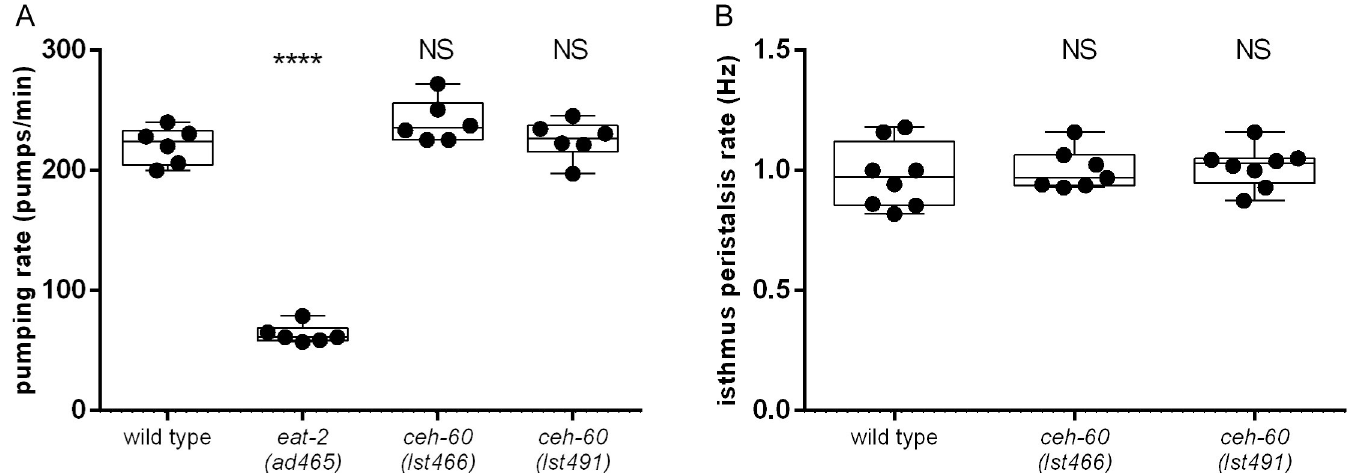
Fig 4. ceh-60 mutants have normal pharyngeal functions. (A) Wild-type animals and ceh-60 mutant animals have similar pumping rates on food, while eat-2 mutants pump significantly slower. Each dot represents one animal (N), imaged thrice for 15 seconds. Pumping rates were averaged per animal. ���� p < 0.0001. NS = not significant. N = 6. (B) Wild-type animals and ceh-60 mutants have similar isthmus peristalsis or “gulp” rates. NS = not significant. N � 6.